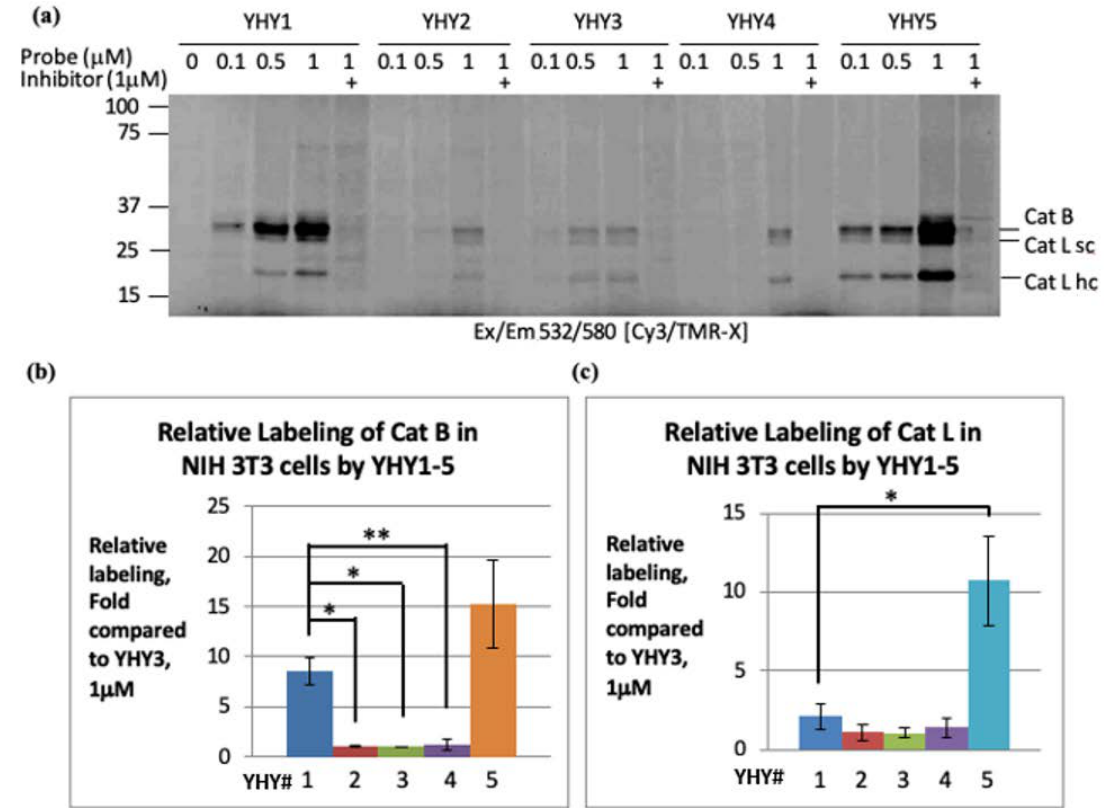
Figure 2. Cell permeability and potency evaluation of YHY1–5 toward Cat B and L. An intact monolayer of NIH-3T3 cells was pretreated with the cathepsin inhibitor GB111-NH 2 or with vehicle DMSO for 1 h, followed by labeling with YHY1–5 ABPs at indicated concentrations for 6 h. Equal protein in crude detergent lysates were resolved by SDS-PAGE then visualized by a scan of the gel with a Typhoon flatbed laser scanner. The experiment was repeated 3 times ( a ). Cathepsin B bands of 1 µ M probe treatment were quantified by Image J. Data are represented as an average of fold increase relative to YHY3 ( b ). Cathepsin L bands at 22 kDa ( c ), were quantified as in ( b ). Statistical significance was determined using an unpaired, two-tailed t -test. A p ≤ 0.05 was considered statistically significant. Error bars represent mean ± SD of 3 technical replicates per probe. * p ≤ 0.05, ** p ≤